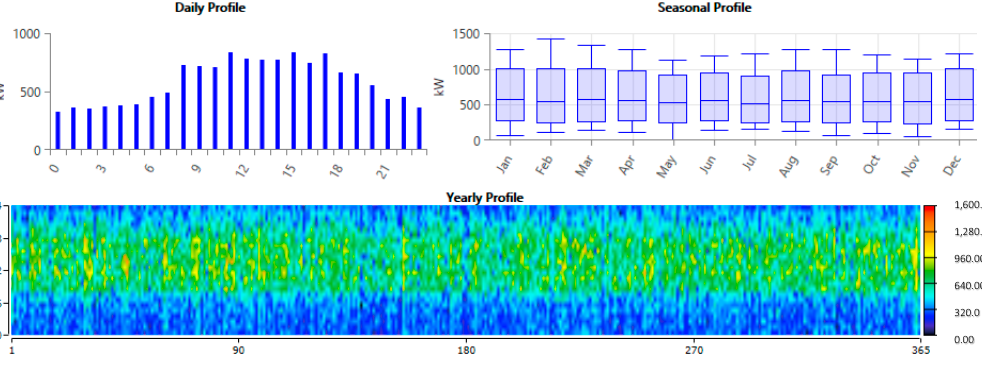
Figure 1. Electrical load in a without thermal system.